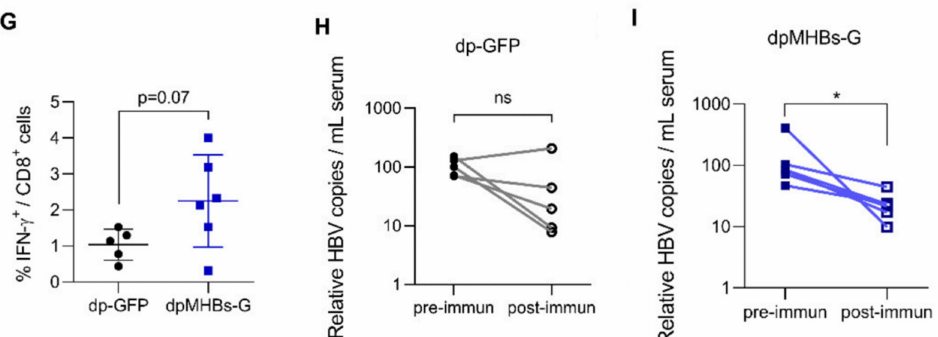
Figure 5. VLV dp prime-boost immunization significantly reduces HBV in mice with pre-existing intermediate HBV antigen levels. ( A ) Mice received 1 × 10 11 genome copies of AAV-HBV followed by VLV prime-boost immunization. Analyses of T cell responses and antigenemia were then performed. ( B ) Serum HBsAg levels in the mice at the indicated time points pre- and post-immunization. ( C ) Serum ALT pre- and post-immunization. ( D ) Serum HBeAg levels in the mice pre- and post-immunization. ( E ) Liver RNA was quantified by RT-qPCR with GAPDH as the endogenous control 3 weeks after the final boost. ( F ) IFN- γ -producing cells in the spleen of immunized mice after stimulation with Core and S antigen peptides. ( G ) Percentage of IFN- γ -producing cells in the IHL of immunized mice after stimulation with S antigen peptides. ( H , I ) Serum HBV DNA pre- and post-immunization with ( H ) dp-GFP and ( I ) dpMHBs-G. * p < 0.05, ns = not significant compared to pre-immunization.